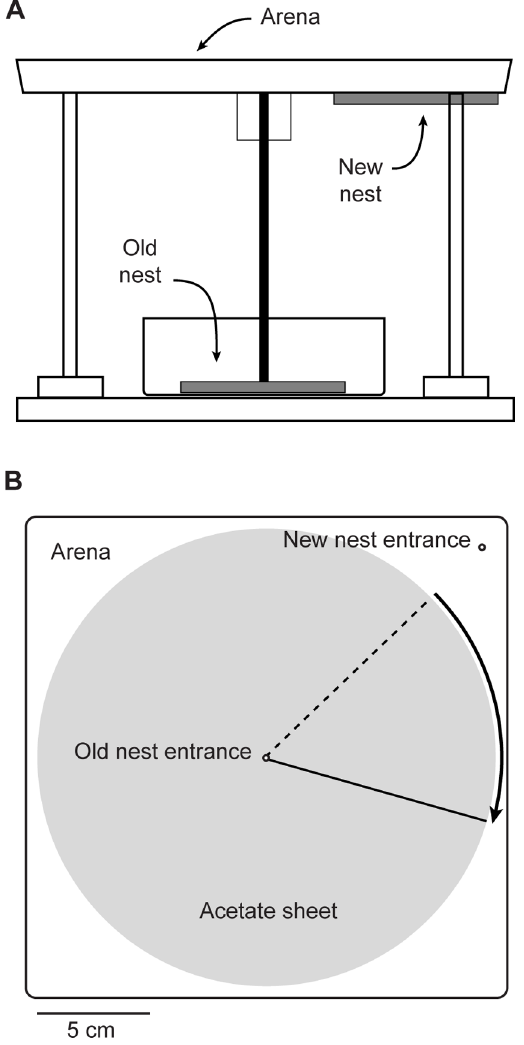
Figure 1. Apparatus for manipulation of substrate cues during colony emigration. A) Side view shows a box containing the old nest below an arena mounted on risers. The new nest was fastened to the bottom of one corner of the arena, which ants reached by climbing a wooden dowel. A Fluon-coated collar guided the ants through an entrance hole to the upper surface of the arena. B) Top view shows the arena floor carpeted with a transparent acetate sheet. In the midst of each emigration, the sheet was rotated 60 u clockwise. Emigrating ants were observed to determine if they continued to walk toward the new nest (dashed line) or shifted their headings to match the new substrate position (solid line).